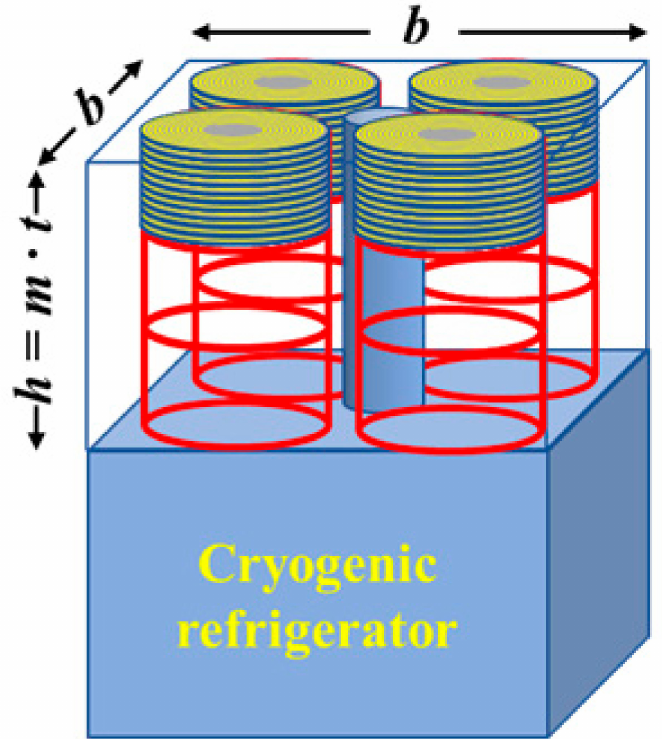
Figure 16. Decrease in m from 600 to 200 and the installation of eight more wafer stacks in comparison with Figure